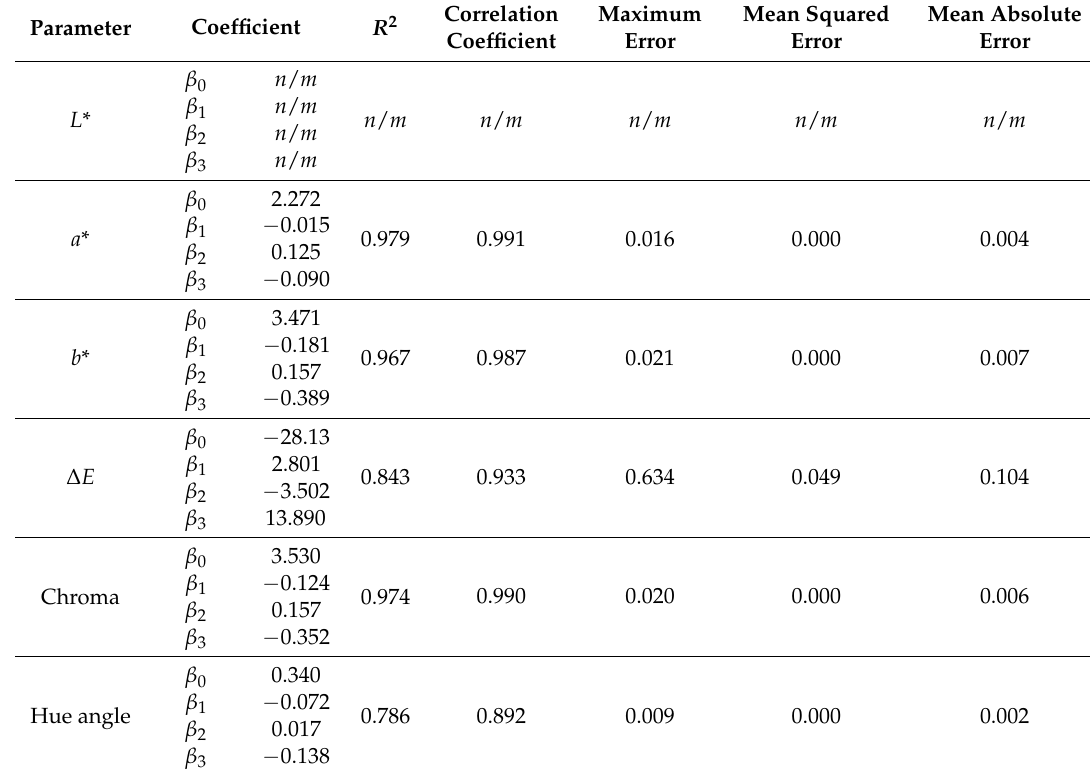
Table 8. Linear regression models coefficients for description of colour component change during storage of V1KMK ( α = 95%) estimated using the Eureqa